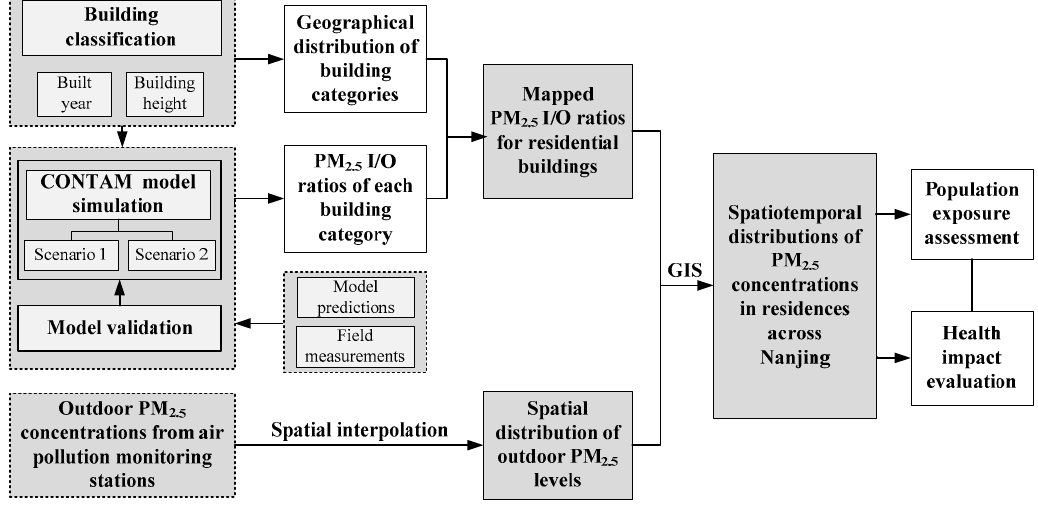
Figure 2. A flow chart of the study for indoor PM 2.5 concentrations in residences. (I/O: indoor/outdoor).